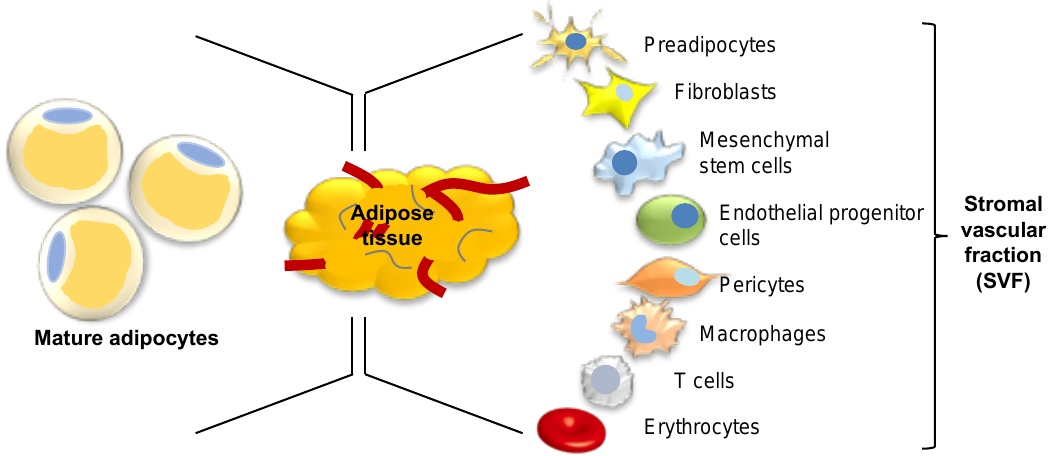
Figure 1. Composition of adipose tissue. Adipose tissue comprises a complex mixture of cells, one-third of which are mature adipocytes. Following enzymatic digestion, the remaining two-thirds contains multiple cell types known as the stromal vascular fraction.